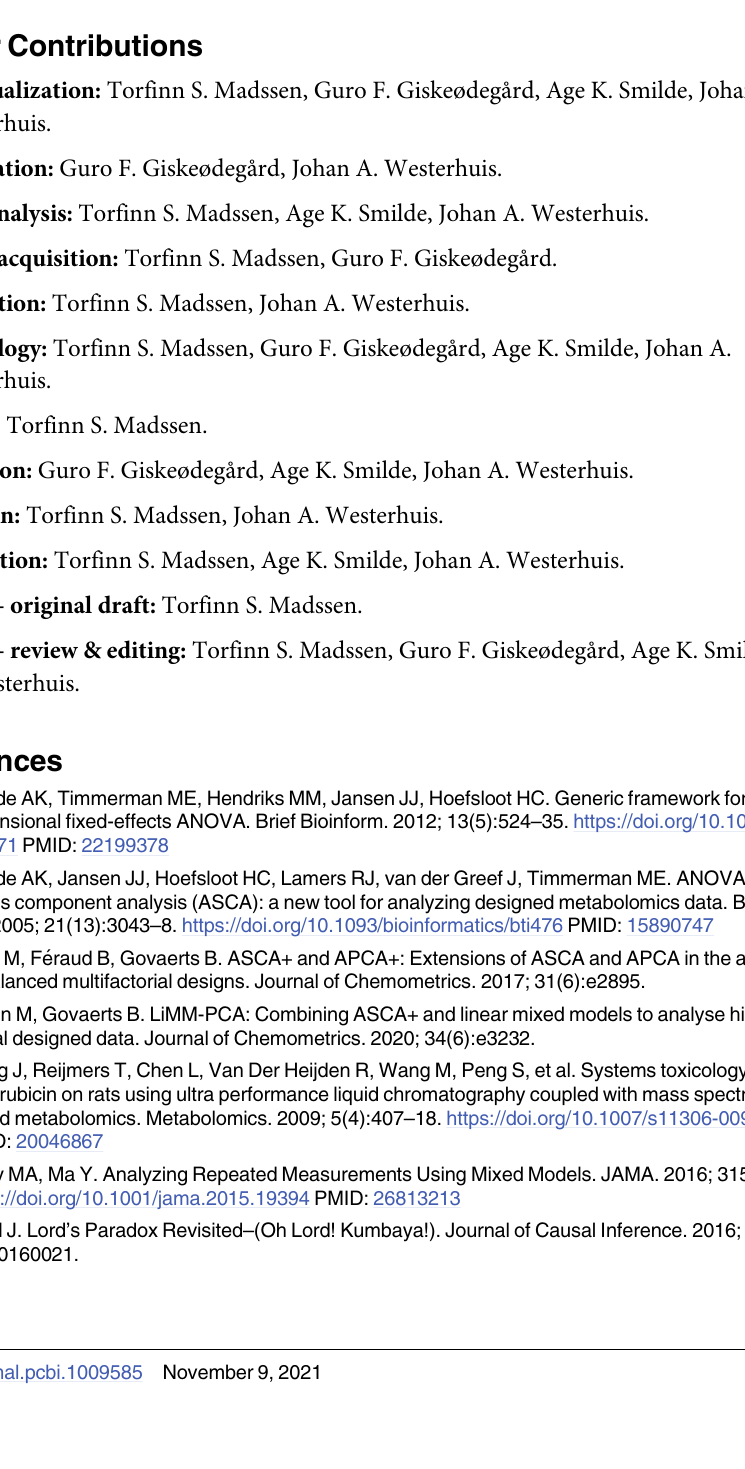
S2 Table. Table with results from analyses with individual linear mixed models (uncon- strained LDA-model) on each metabolite for the bariatric surgery